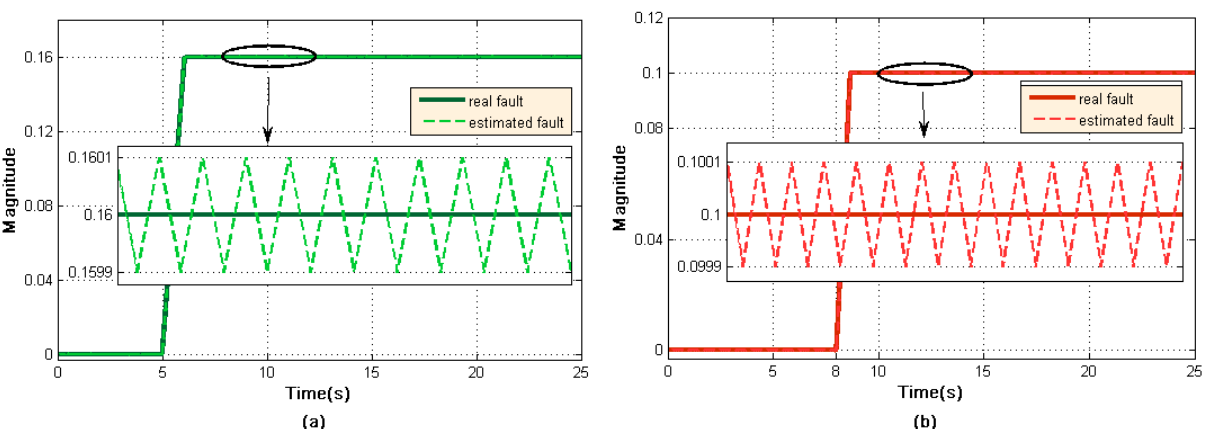
Figure 6. Diagnosis of inter-turn short circuit fault in the electrical machine of TWT: ( a ) severity = 16% of: b -phase at t = 5 sand ( b ) severity = 10% of: c -phase at t = 8 s.